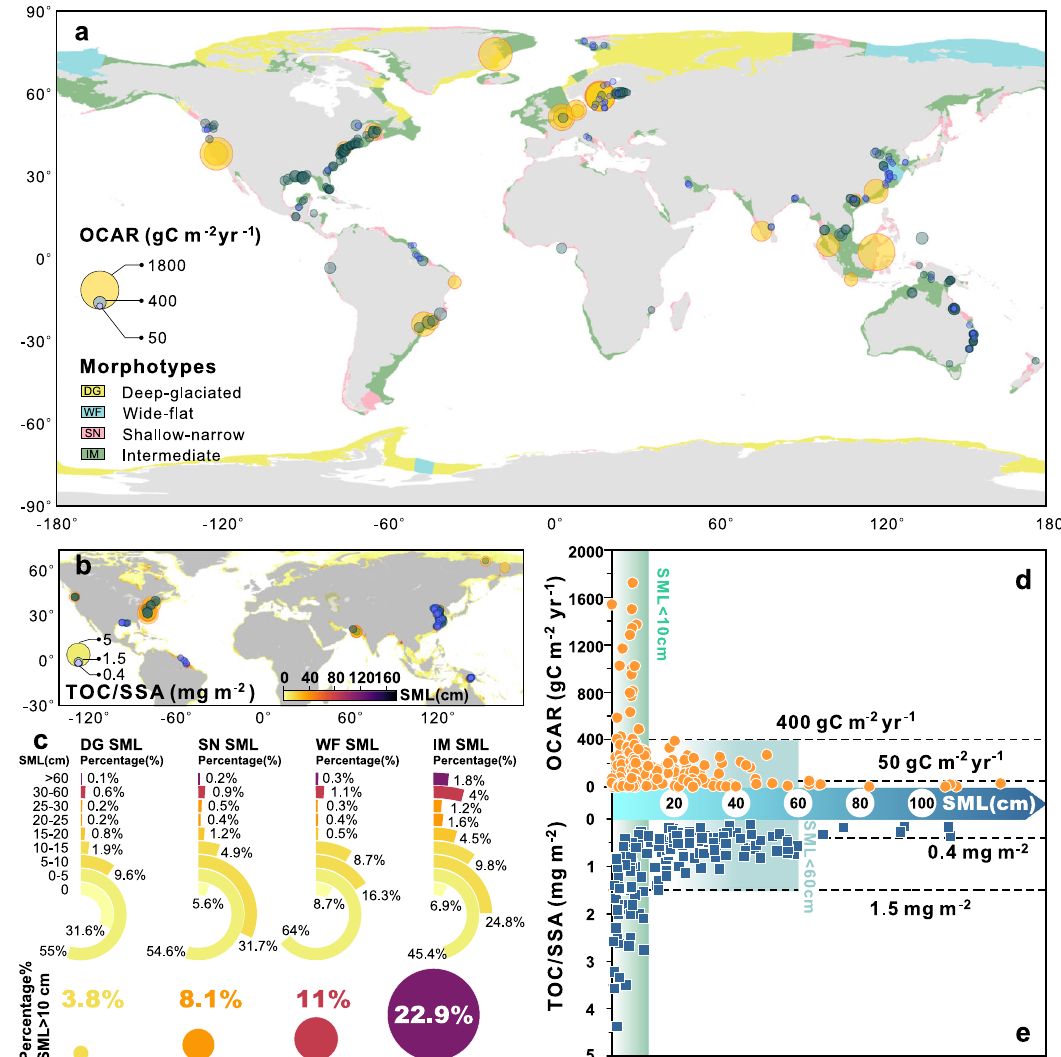
Fig. 4 | Impacts of sediment mixed layer (SML) on organic carbon storage. a Distribution of organic carbon accumulation rates (OCAR) in the global coastal ocean (reproduced with permission from “ Harris, P. T. & Macmillan-Lawler,